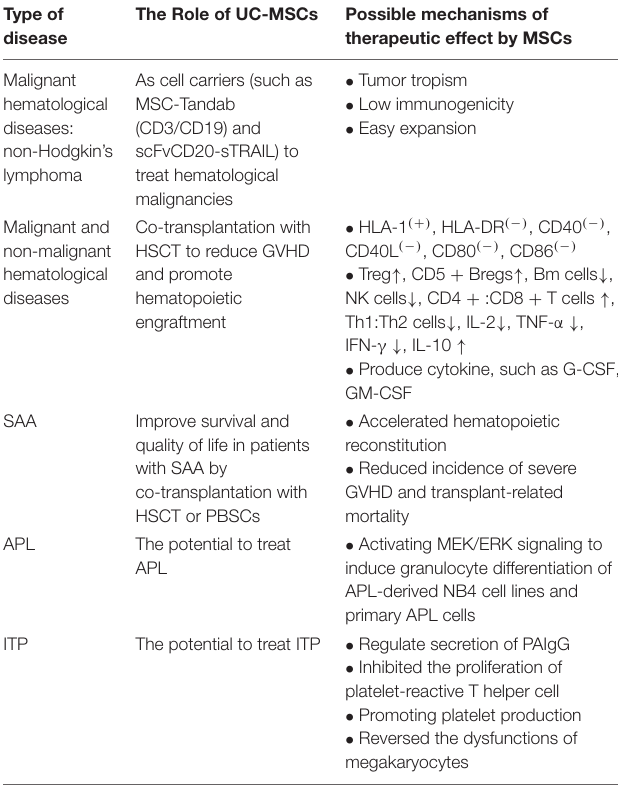
TABLE 1 | Application of UC-MSCs in hematologic